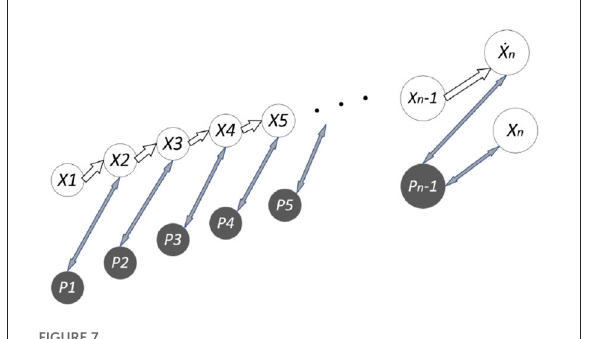
FIGURE7 Improved observation value selection principle